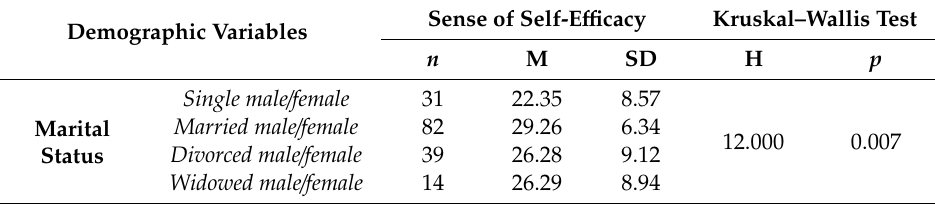
Table 5. Marital status and the level of a sense of self-e ffi cacy in the respondents. Demographic